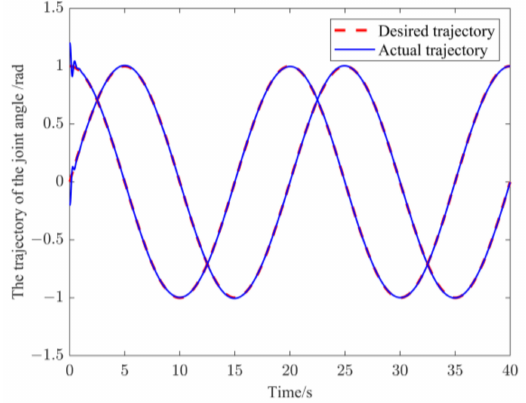
Figure 4. The trajectories of the joint angle q